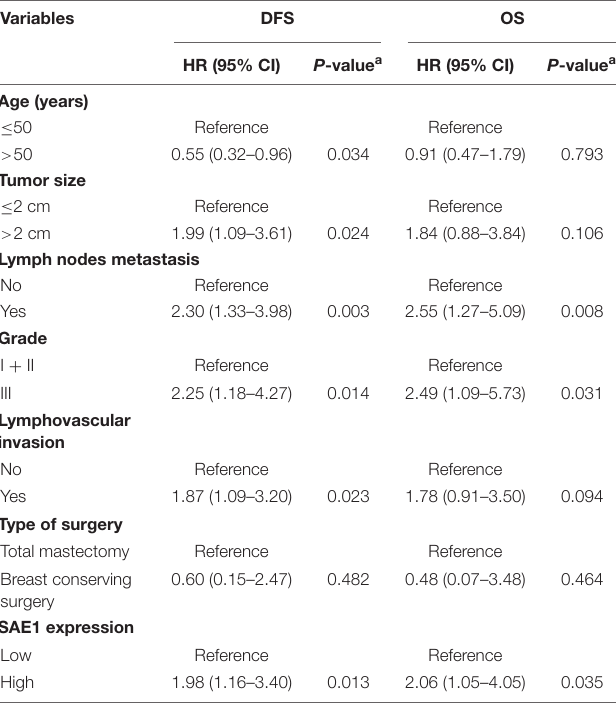
TABLE 2 | Univariate Cox proportional hazard model for disease-free survival (DFS) and overall survival (OS) in TNBC patients with adjuvant chemotherapy.